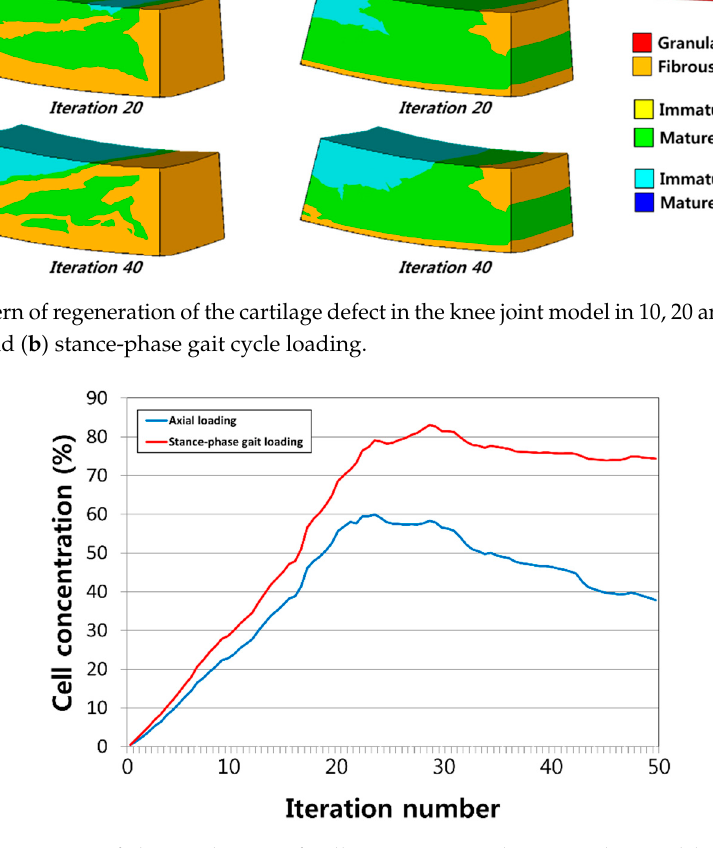
Figure 7. Percentage of each tissue type formation in the axial loading and the stance-phase gait loading model after 40 iterations. 4. Discussion T he most important finding of this study was that different results were found with respect to the loading conditions in a real knee joint model for mechano-biological tissue differentiation. Cartilage defects possess a very limited intrinsic healing capacity. Curl et al. described 53,569 hyaline cartilage lesions in 19,827 patients that received total knee arthroplasty [28]. Similarly, a more recent prospective survey of 993 consecutive knee arthroscopies showed evidence of articular cartilage abnormality in 66% of the patients [29]. Several techniques for articular cartilage defect treatment have been described recently with various results and indications [24,30]. Microfracture represents a widely used technique for the repair of symptomatic articular cartilage defects of the knee [31,32]. The penetration of the subchondral bone plate in these defects causes clot formation in the defect. This clot contains pluripotent, marrow-derived MSCs, which can induce fibrocartilage repair as they possess varying amounts of type II collagen [30]. However, the microfracture technique is limited for treating large-sized defects. Small defects can spontaneously undergo repair with the